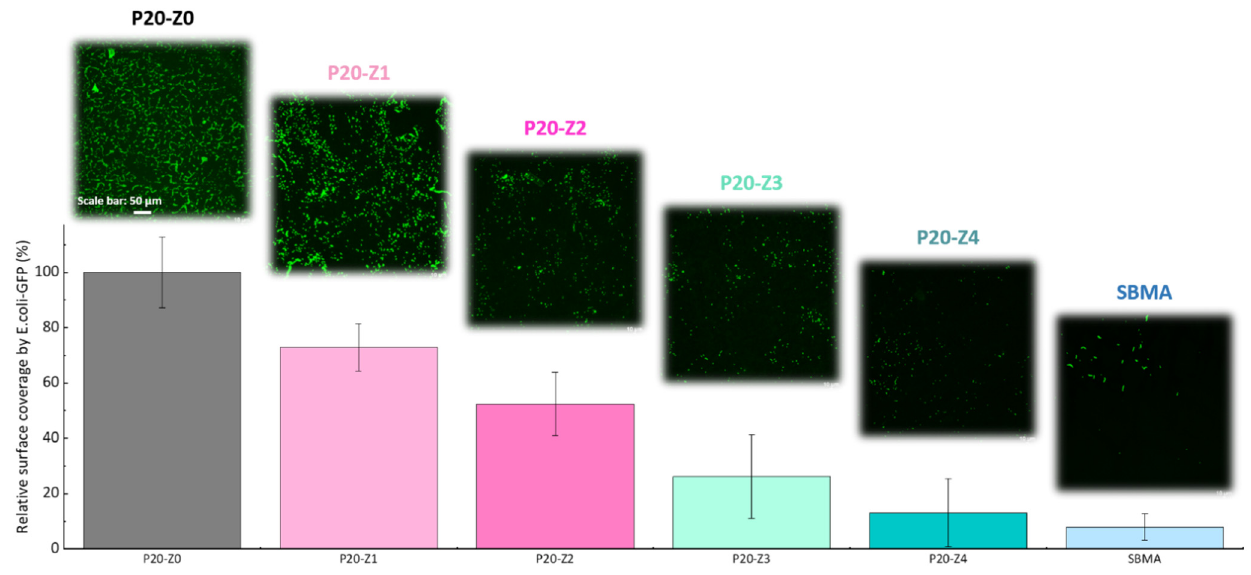
Figure 9. Effect of zwitterionic copolymer on the resistance of membranes to the attachment of Escherichia coli .